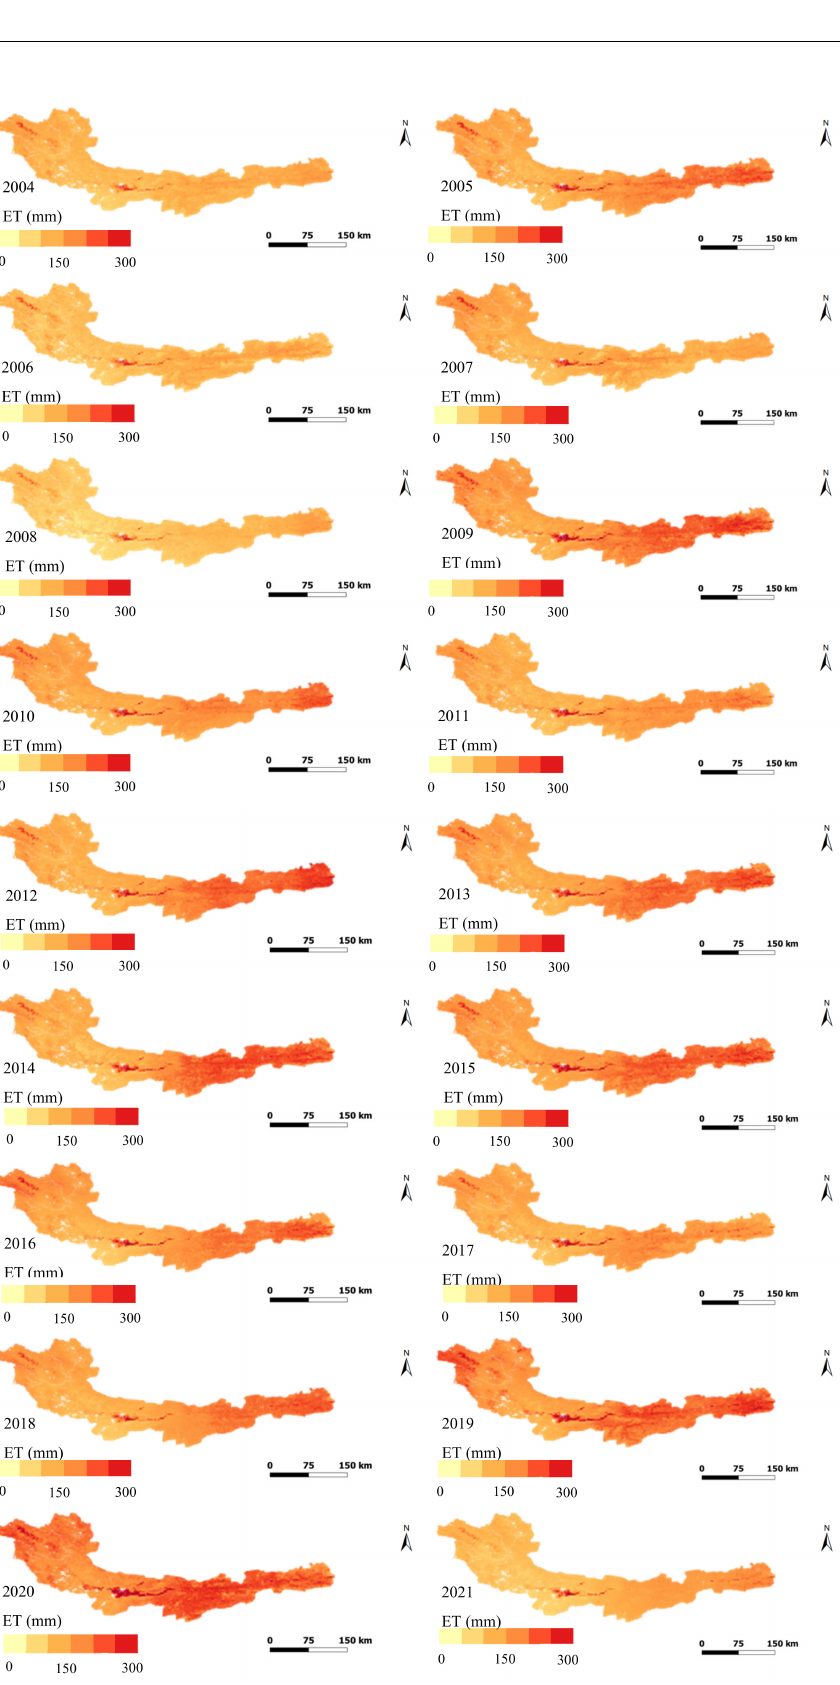
Figure 9. The spatial–temporal distribution of annual evapotranspiration (mm) from the MODIS product (MOD16A2) derived from GEE in the period of